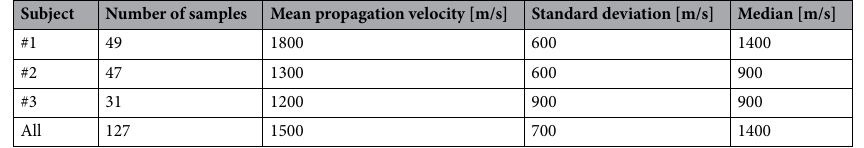
Table 2. Results of propagation velocity measurements. Number of samples indicates how many measurements were included to the overall result. For Subject #1 and #2 only 1 and 3 samples were rejected due to noise or motion artifacts. For Subject #3 the biggest impact of noise or motion artifact was observed—19 samples were rejected due to large distortions of the QRS morphology—as mentioned in text. Note, that mean propagation velocity and its median has the biggest value for Subject #1—youngest